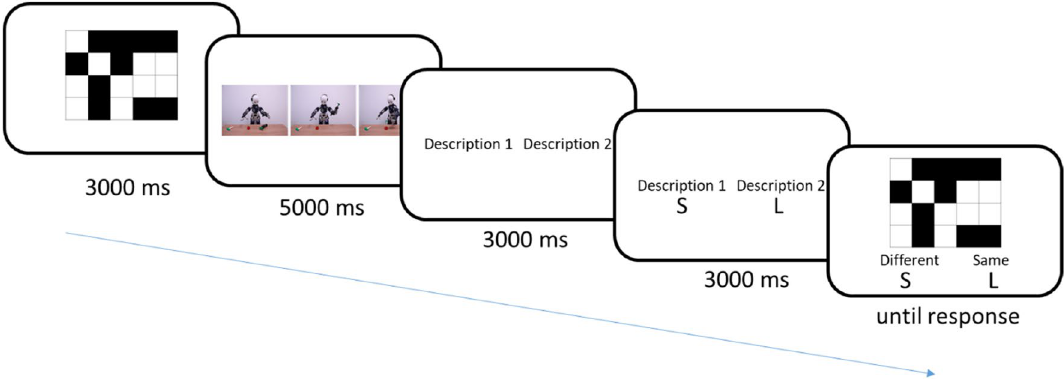
Figure 5. Experiment 2 trial sequence (without the fixation